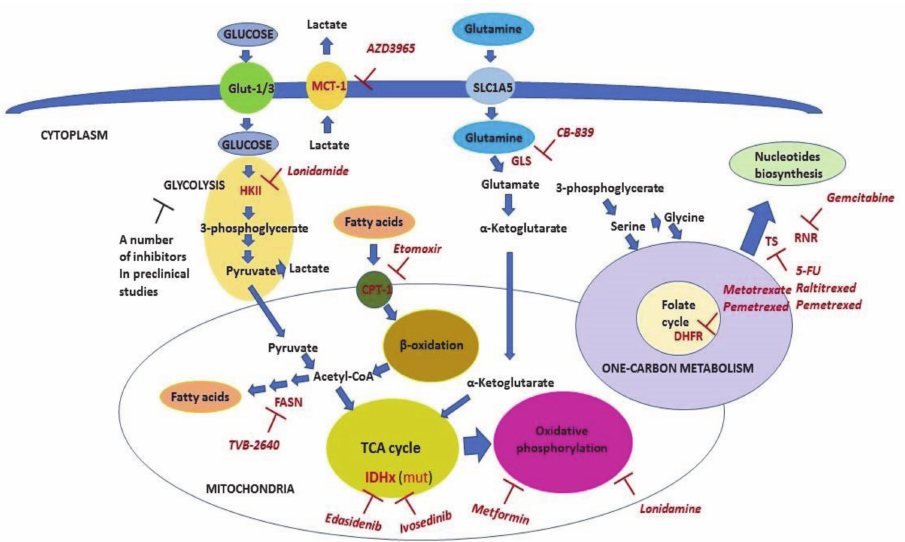
Figure 4. The scheme of metabolic pathways which are targeted in clinical oncology. The scheme shows metabolic pathways and the key enzymes (shown in red) involved in these processes. In- hibitors that are used as anticancer therapeutics (shown in pink) are also shown. Malignant cells consume energy mainly through utilizing glucose, fatty acids, and glutamine. The process of gly- colysis begins with glycose phosphorylation and culminates with pyruvate, which then enters the TCA cycle in mitochondria. Pyruvate is also converted to lactate to maintain high levels of glycolysis. Lactate is exported from the cells mainly by Monocarboxylate carrier 1 (MCT-1) (which is inhibited by AZD3965 and lonidamide) to prevent intracellular acidosis. Fatty acids are transported inside mitochondria by Carnitine Palmitoyltransferase (CPT-1) (which is inhibited by Etomoxir). This step limits their beta-oxidation. The latter is the source of energy consumed by cancer cells via acetyl-CoA entering the TCA cycle. Additionally, cancer cells, unlike nonmalignant ones, are able to synthesize fatty acids. Fatty acid synthase (FASN) (which is inhibited by TVB-2640) mediates the limiting repeating step in this process. Mutated enzymes of the TCA cycle, isocitrate dehydrogenase 1 (IDH1) and IDH2, can be targeted by ivosedinib and edasidenib, respectively. Glutamine is converted to glu- tamate by Glutaminase (GLS) enzyme (which is inhibited by CB-839) and then to alpha-ketoglutarate in the next step reaction. Alpha-ketoglutarate, in turn, enters the TCA cycle and may be used for either energy production or anabolic metabolism (anaplerosis). The pivotal part of the one-carbon metabolism is the folate cycle, which can be inhibited by methotrexate and pemetrexed via inhibition of DHFR. The one-carbon metabolism provides one-carbon donor groups for biosynthesis of different compounds including nucleotides that are the rate-limiting factor for DNA synthesis and hence, proliferation of cancer cells. Fluouracil (5-FU), raltitrexed, and pemetrexed all inhibit Thymidylate Synthase (TS), whereas gemcitabine inhibits Ribonucleotide reductase (RNR). Detailed explanations are given in the